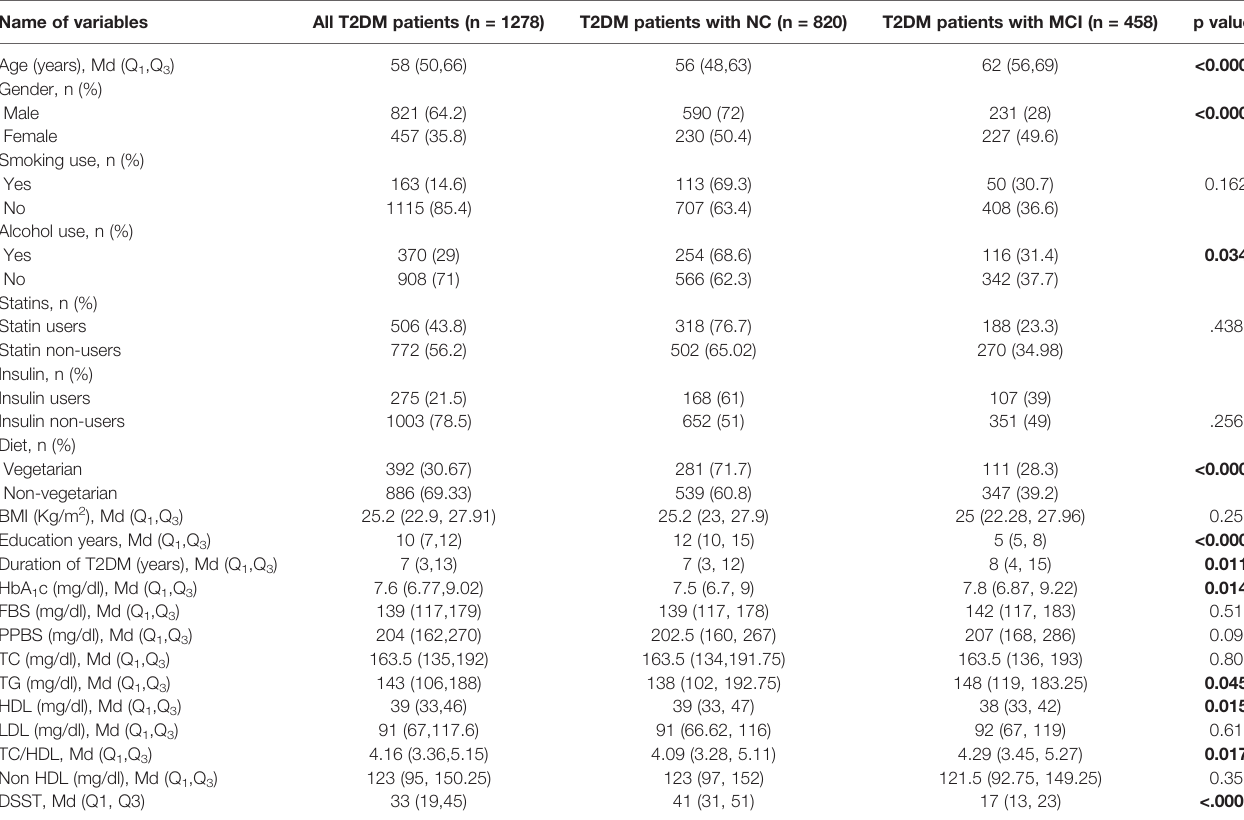
TABLE 2 | Comparison of socio-demographic and clinical characteristics of T2DM patients with NC and MCI (n=1278). Name of variables All T2DM patients (n = 1278) T2DM patients with NC (n =